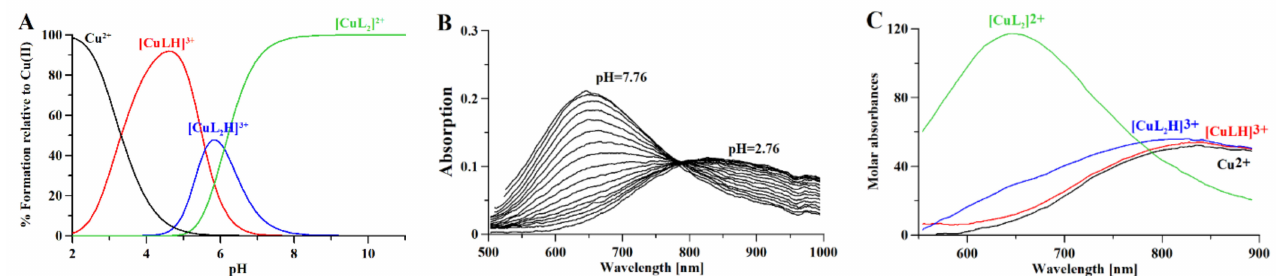
Figure 4. ( A ) Distribution curves for Cooper (II) complexes with metformin calculated on the basis of stability constants (Table 2) with the Hyss program [43]; ( B ) Vis spectra of Cooper (II) complexes with metformin and ( C ) molar absorptivity